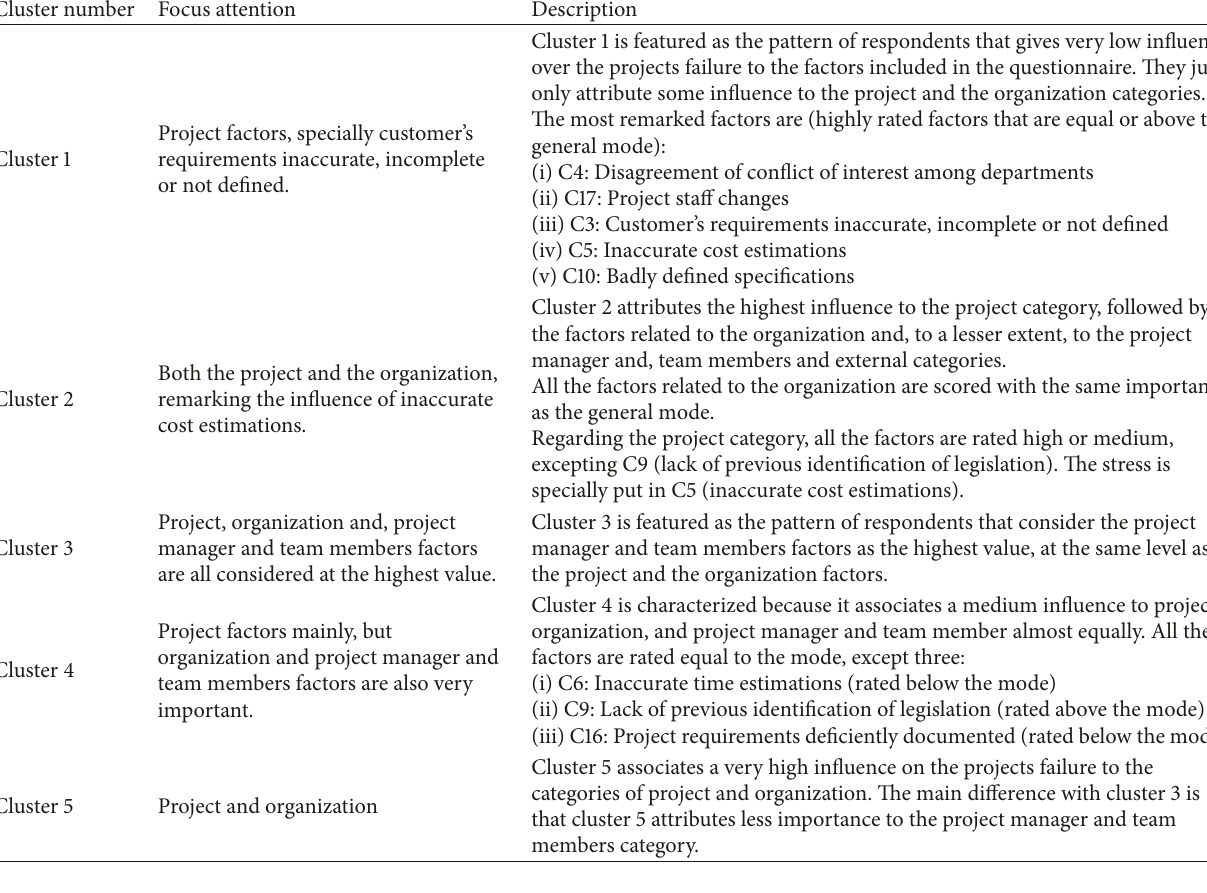
Table 12: Summary of clusters interpretation.